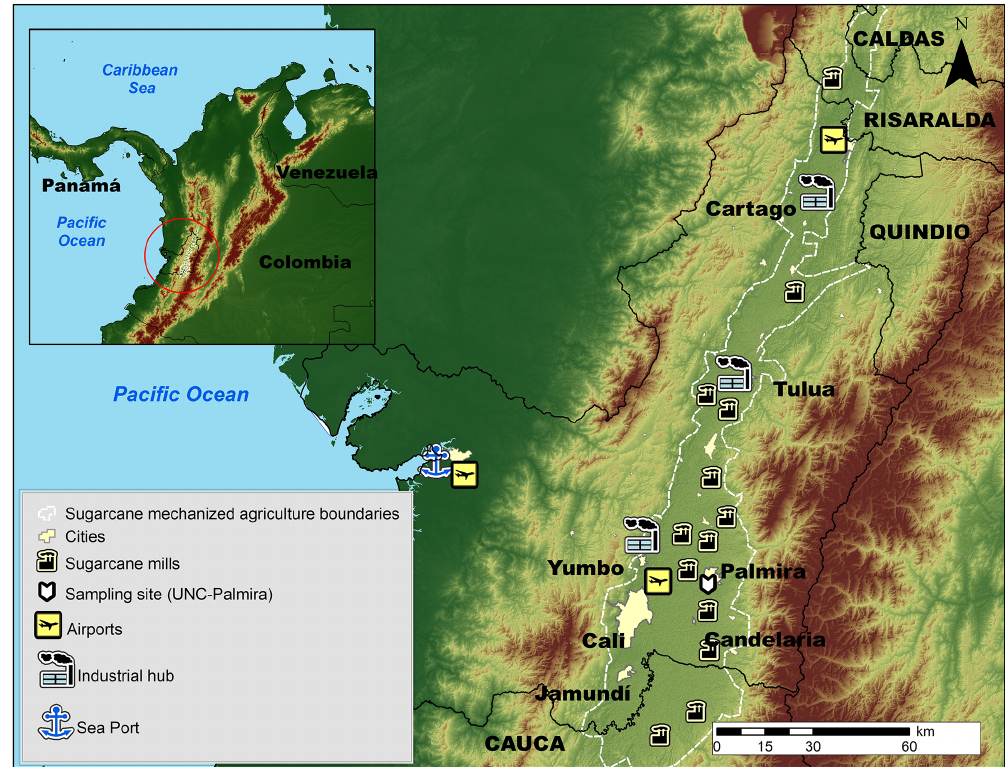
Figure 1. Map of the Cauca River valley (CRV). The inset shows the location of CRV in Colombia and in northern South America. The map shows the main cities in the CRV, including Palmira (312000 inhabitants), our measurement site, Cali, the largest city in the southwest of Colombia, Yumbo, an industrial hub, and the main highways. Sugar mills, which produce sugar, bioethanol, and electric power are also shown. The dashed-line-defined area is CRV’s flattest (slope < 5%) bottomland, where mechanized, intensive sugarcane agriculture takes place. Significant diesel combustion emissions occur along the Buenaventura highway because it is one of the busiest ports in